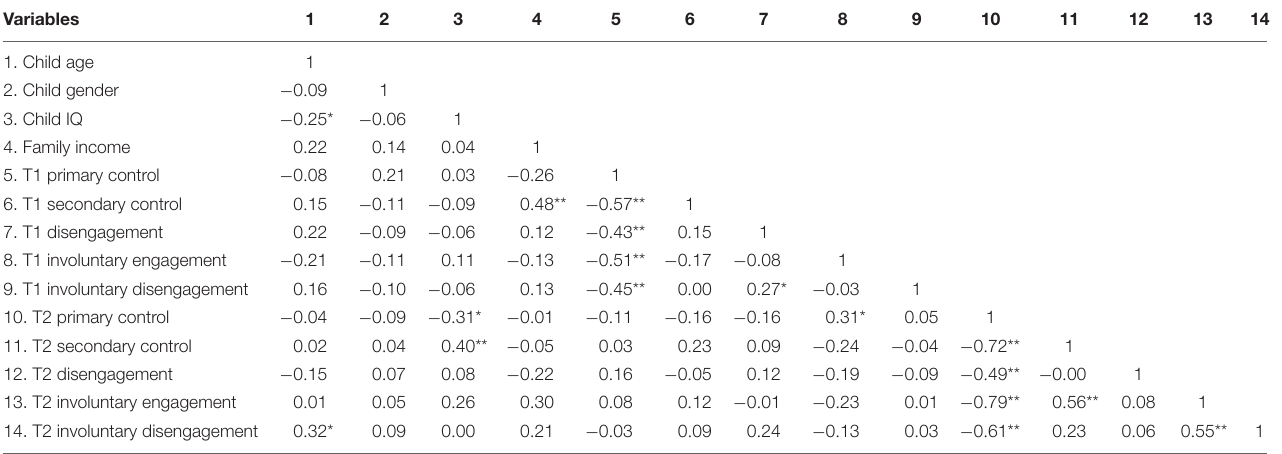
TABLE 4 | Correlations between composite RSQ scores and demographic and medical variables.